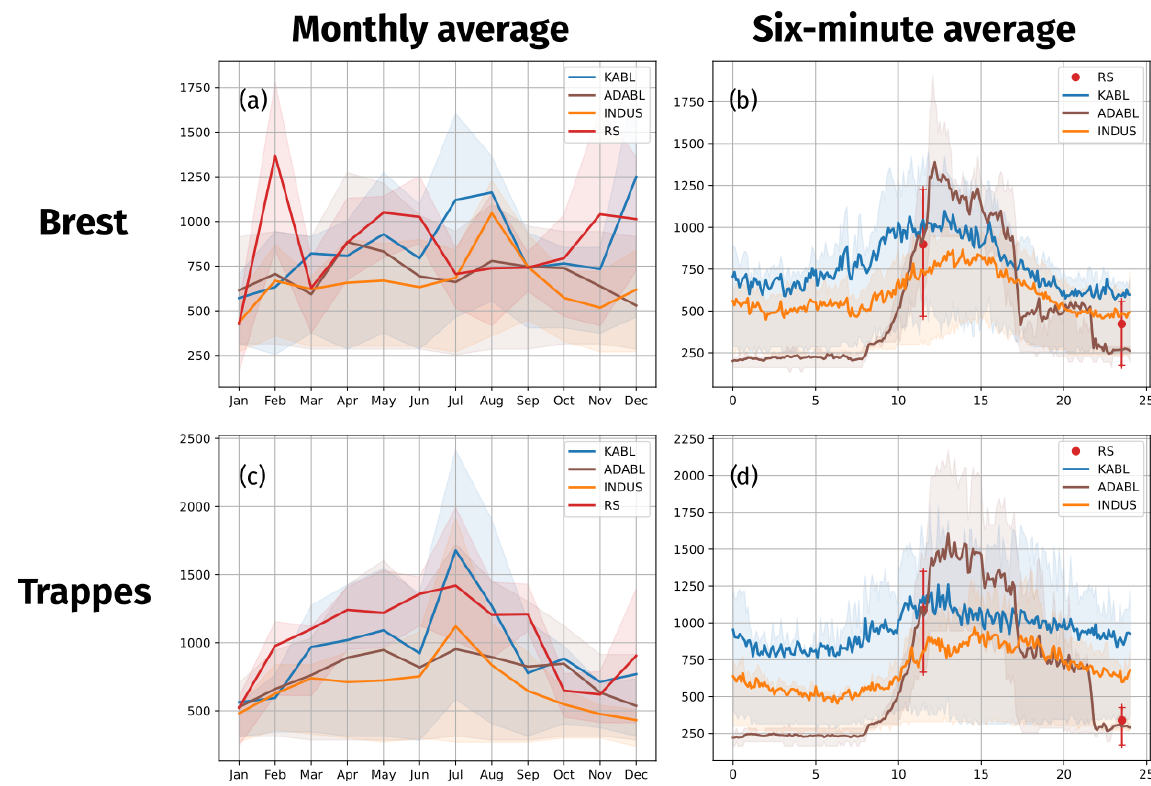
Figure 10. (a, c) Seasonal and (b, d) diurnal cycles of all BLH estimates at both sites. INDUS indicates the manufacturer’s algorithm. Thick lines represent the average, and the shaded area represents the